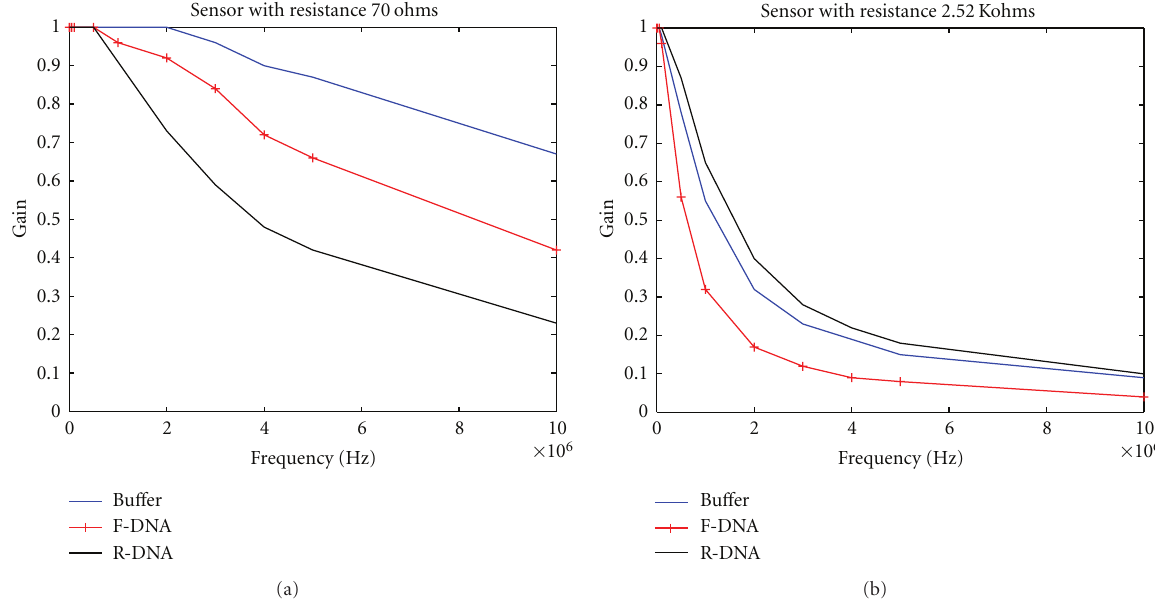
Figure 5: (a) The gain versus frequency plot for a low-resistance sensor detecting the DNA hybridization process. It can be observed that the gain of the hybridized sensor is lower than the original (bu ff er or base). (b) The gain versus frequency plot for a high-resistance sensor in the sensor detecting the DNA hybridization process. It can be observed that the gain of the hybridized sensor is higher than the original (bu ff er or base).